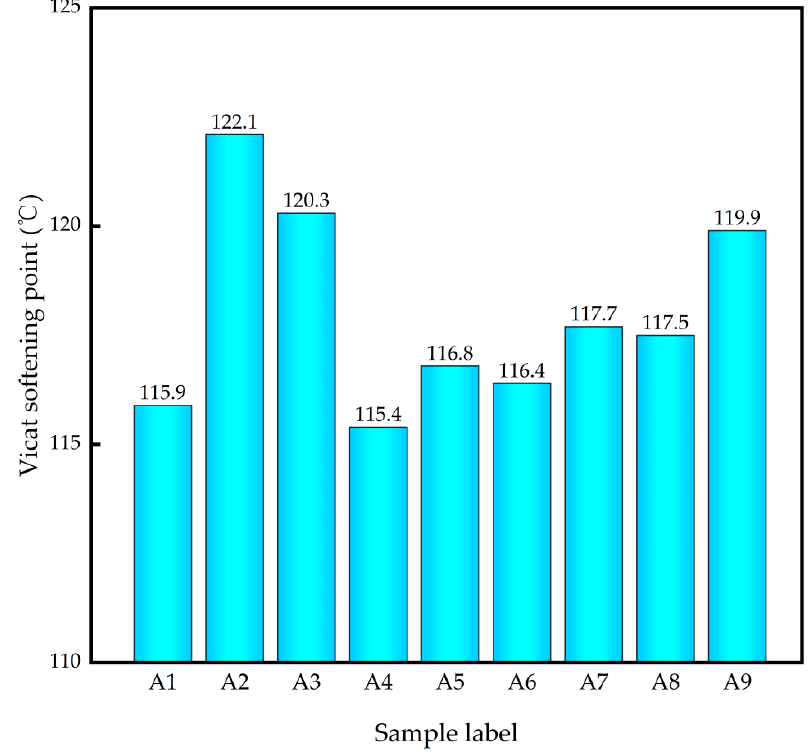
Figure 5. Vicat softening point of different PLA/PBS composites.